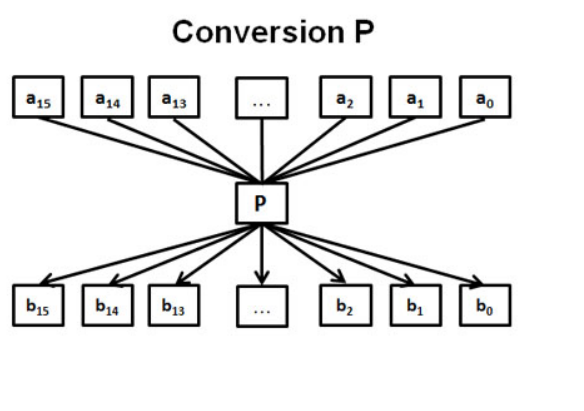
Figure 5: The scheme of conversion P